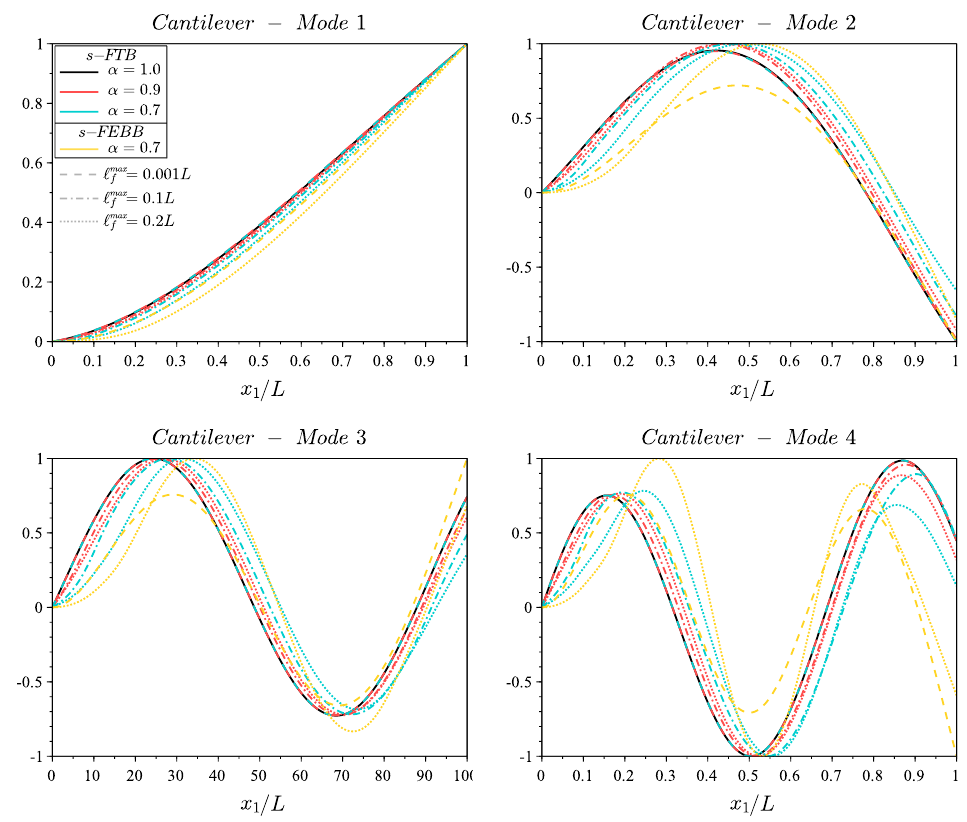
Figure 8. Shape of first four modes of cantilever beam with length to height ratio L / b = 2 and Poisson’s ratio ν = 0.2 for s-FTB model with α = [ 0.9, 0.7 ] and (cid:96) max